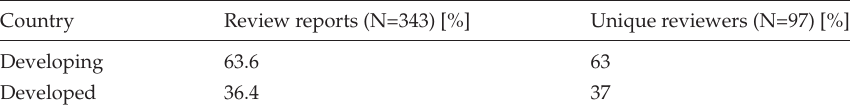
Table 1: Review reports and unique reviewers regarding the institutional affiliation of reviewers [%].